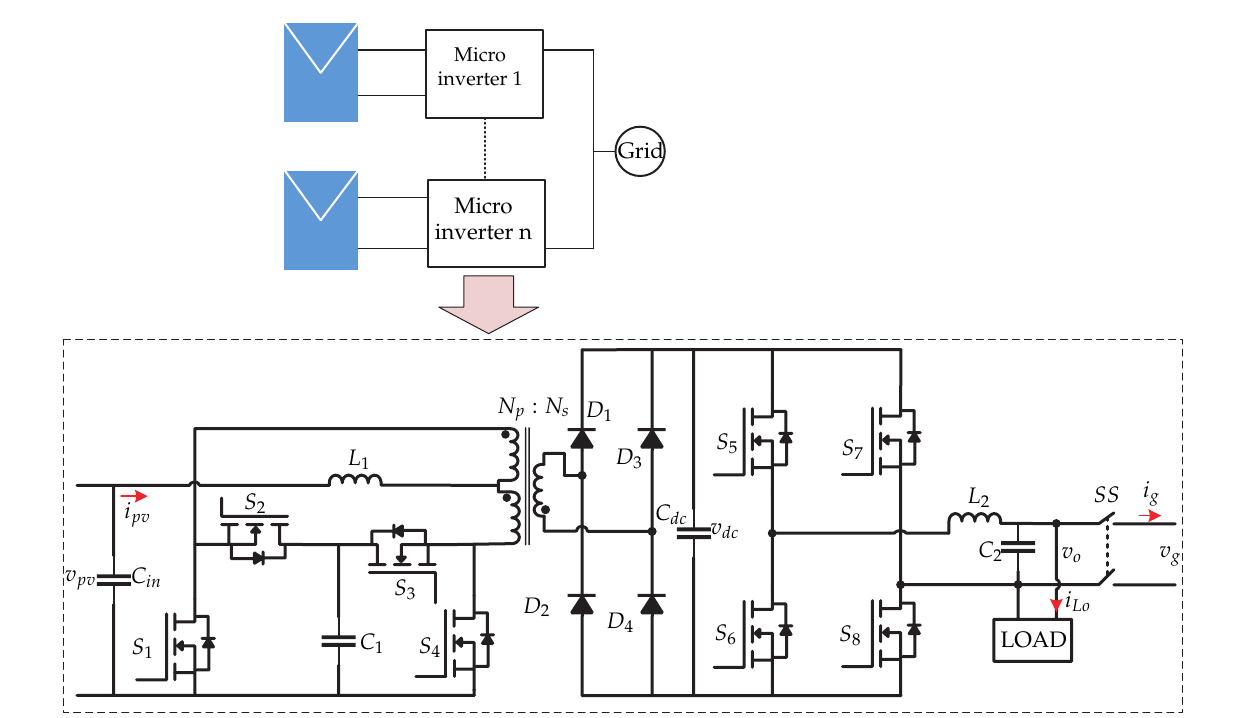
Figure 37. Microinverter’s topology proposed in [73].